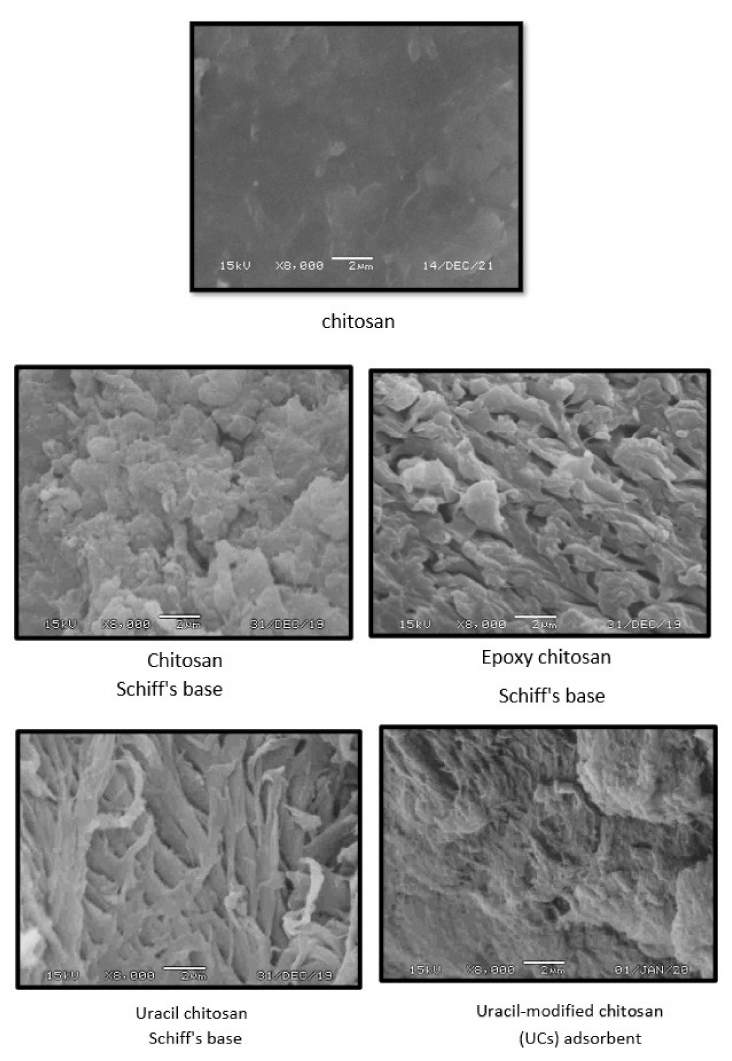
Figure 4. SEM images of the modified chitosan